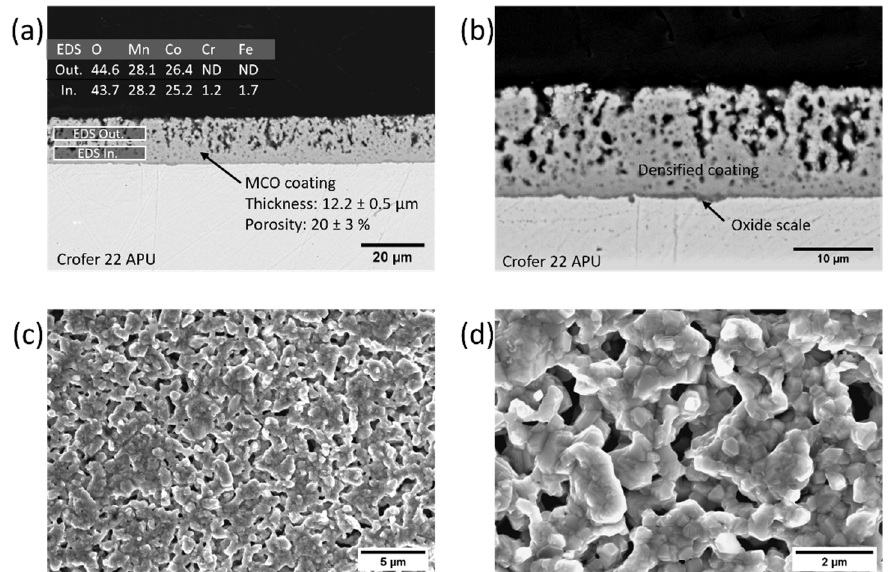
Figure 3. SEM images of 20s_RedOx sample at different magnifications: ( a , b ) backscattered electron images and EDX analysis of the cross section; ( c , d ) secondary electron images of the top view.